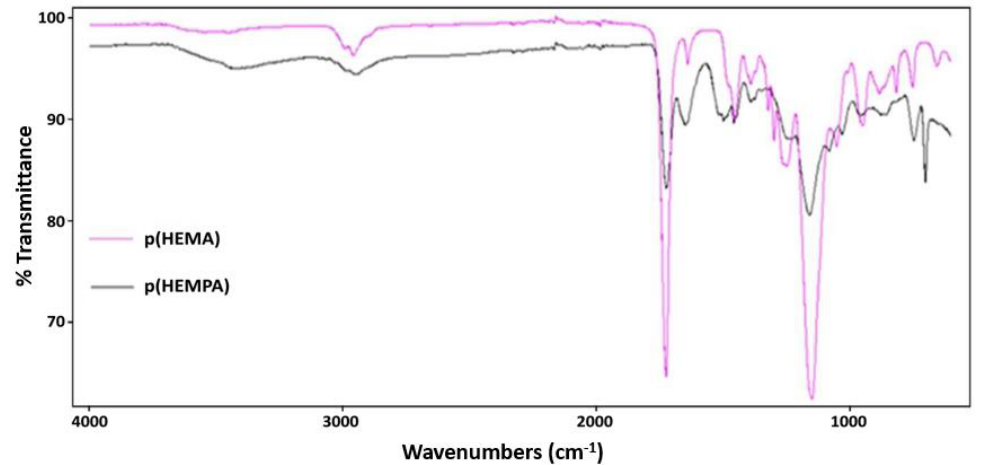
Figure 2. FTIR spectra of p(HEMPA) nanopolymer synthesized using the mini-emulsion polymeri- zation technique.